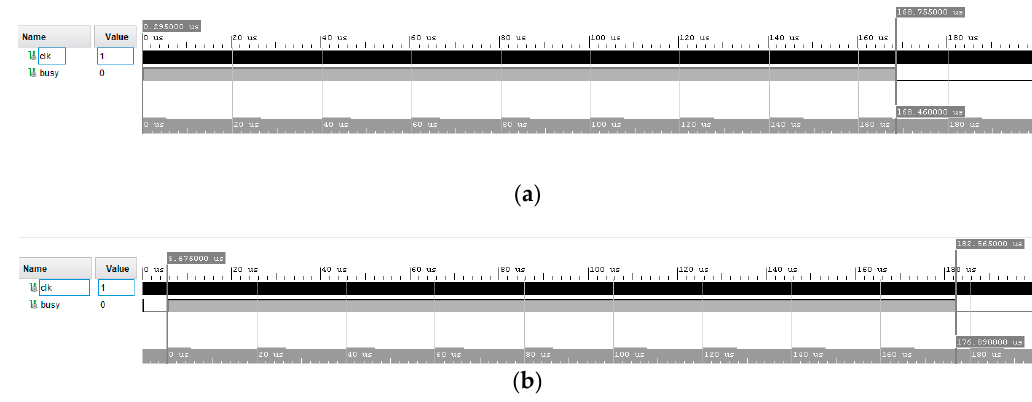
Figure 6. Xilinx Vivado post-implementation results of the kernel with ( a ) Kernel with proposed accumulator, ( b ) Kernel with Simulink IP accumulator.